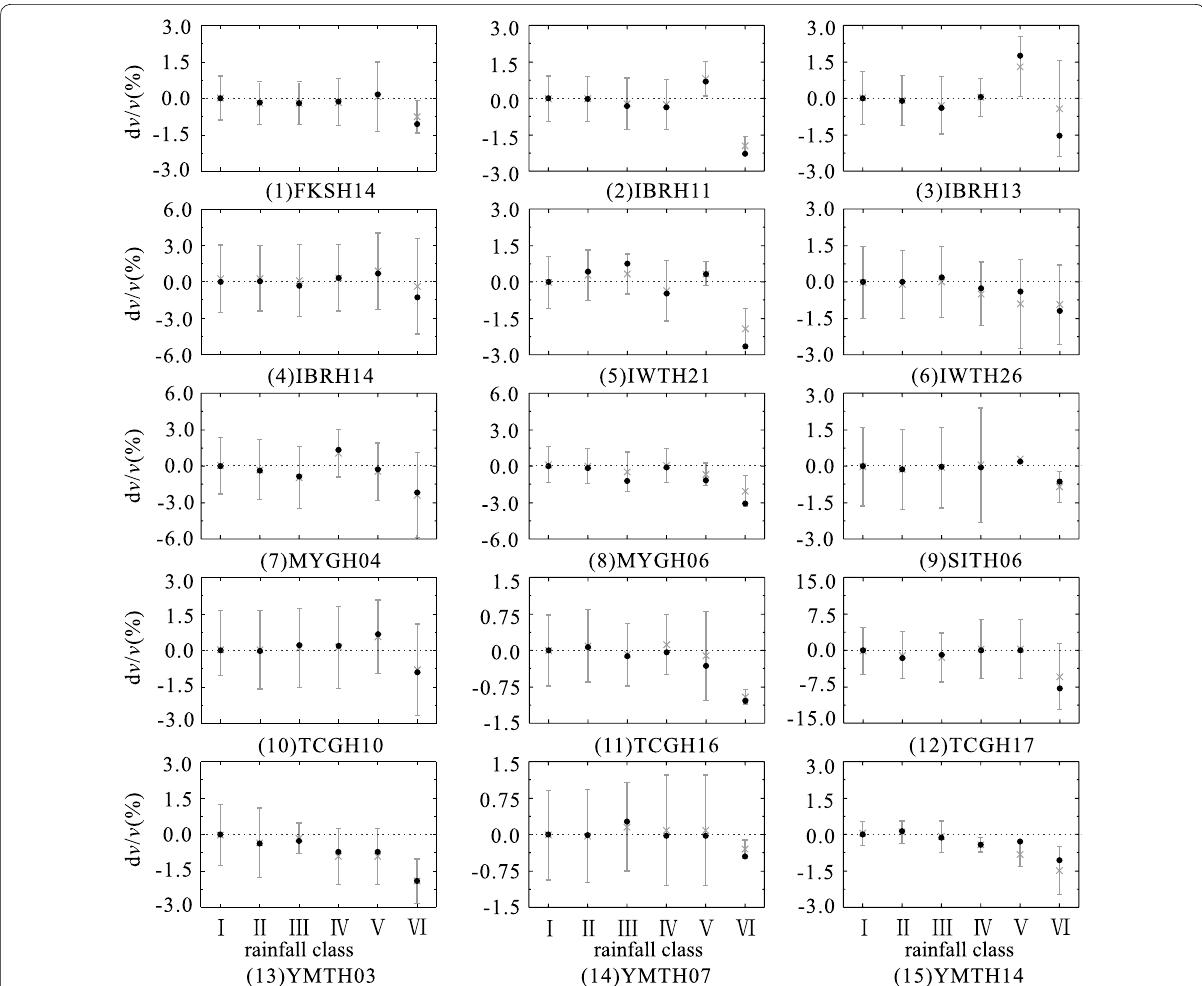
Fig. 4 Relationships between the relative velocity change d v / v and the rainfall classes for 15 seismic stations from KiK‑net. The solid circular represents results from averaged deconvolution functions. The cross with error bar represents the mean value and the standard deviation of single measurements. The velocity does not change obviously when the rainfall class ranges from level II–V, while it is reduced by 1–10% when the rainfall class reaches level